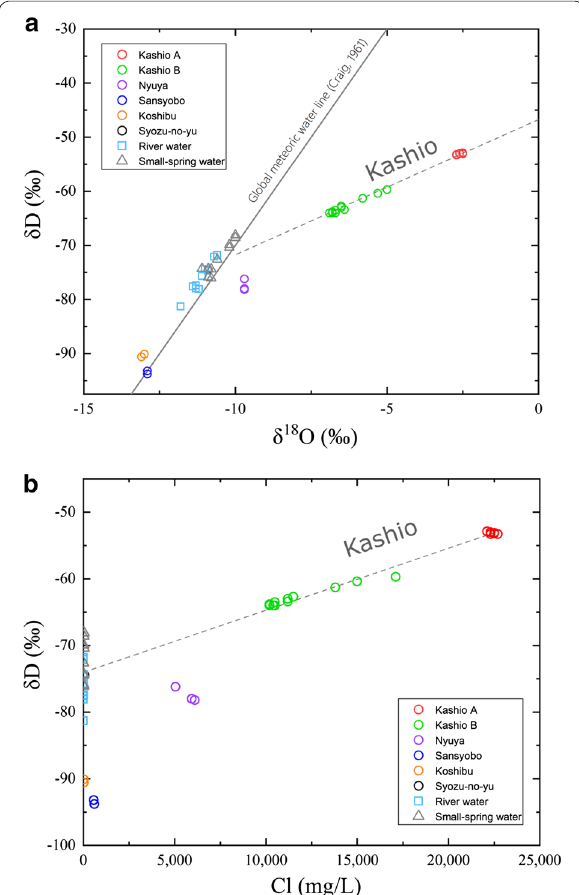
Fig. 3 Relationships between δD and δ 18 O and between δD and Cl concentration in water samples from mineral springs, rivers, and small springs. δD, δ 18 O, and Cl concentration values obtained from Kashio A and B wells follow a linear trend lines in both